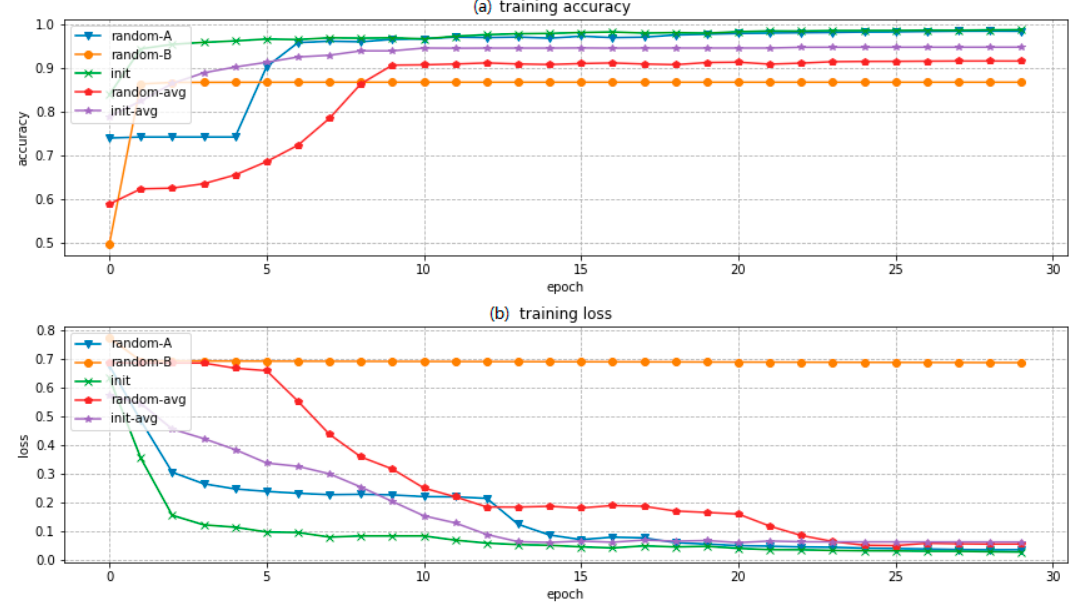
Figure 12. Figures of ( a ) training accuracy curves and ( b ) training loss curves using different supervised learning algorithms.